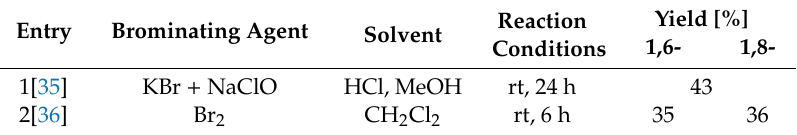
Table 2. Reported bromination reactions of 1-bromopyrene.